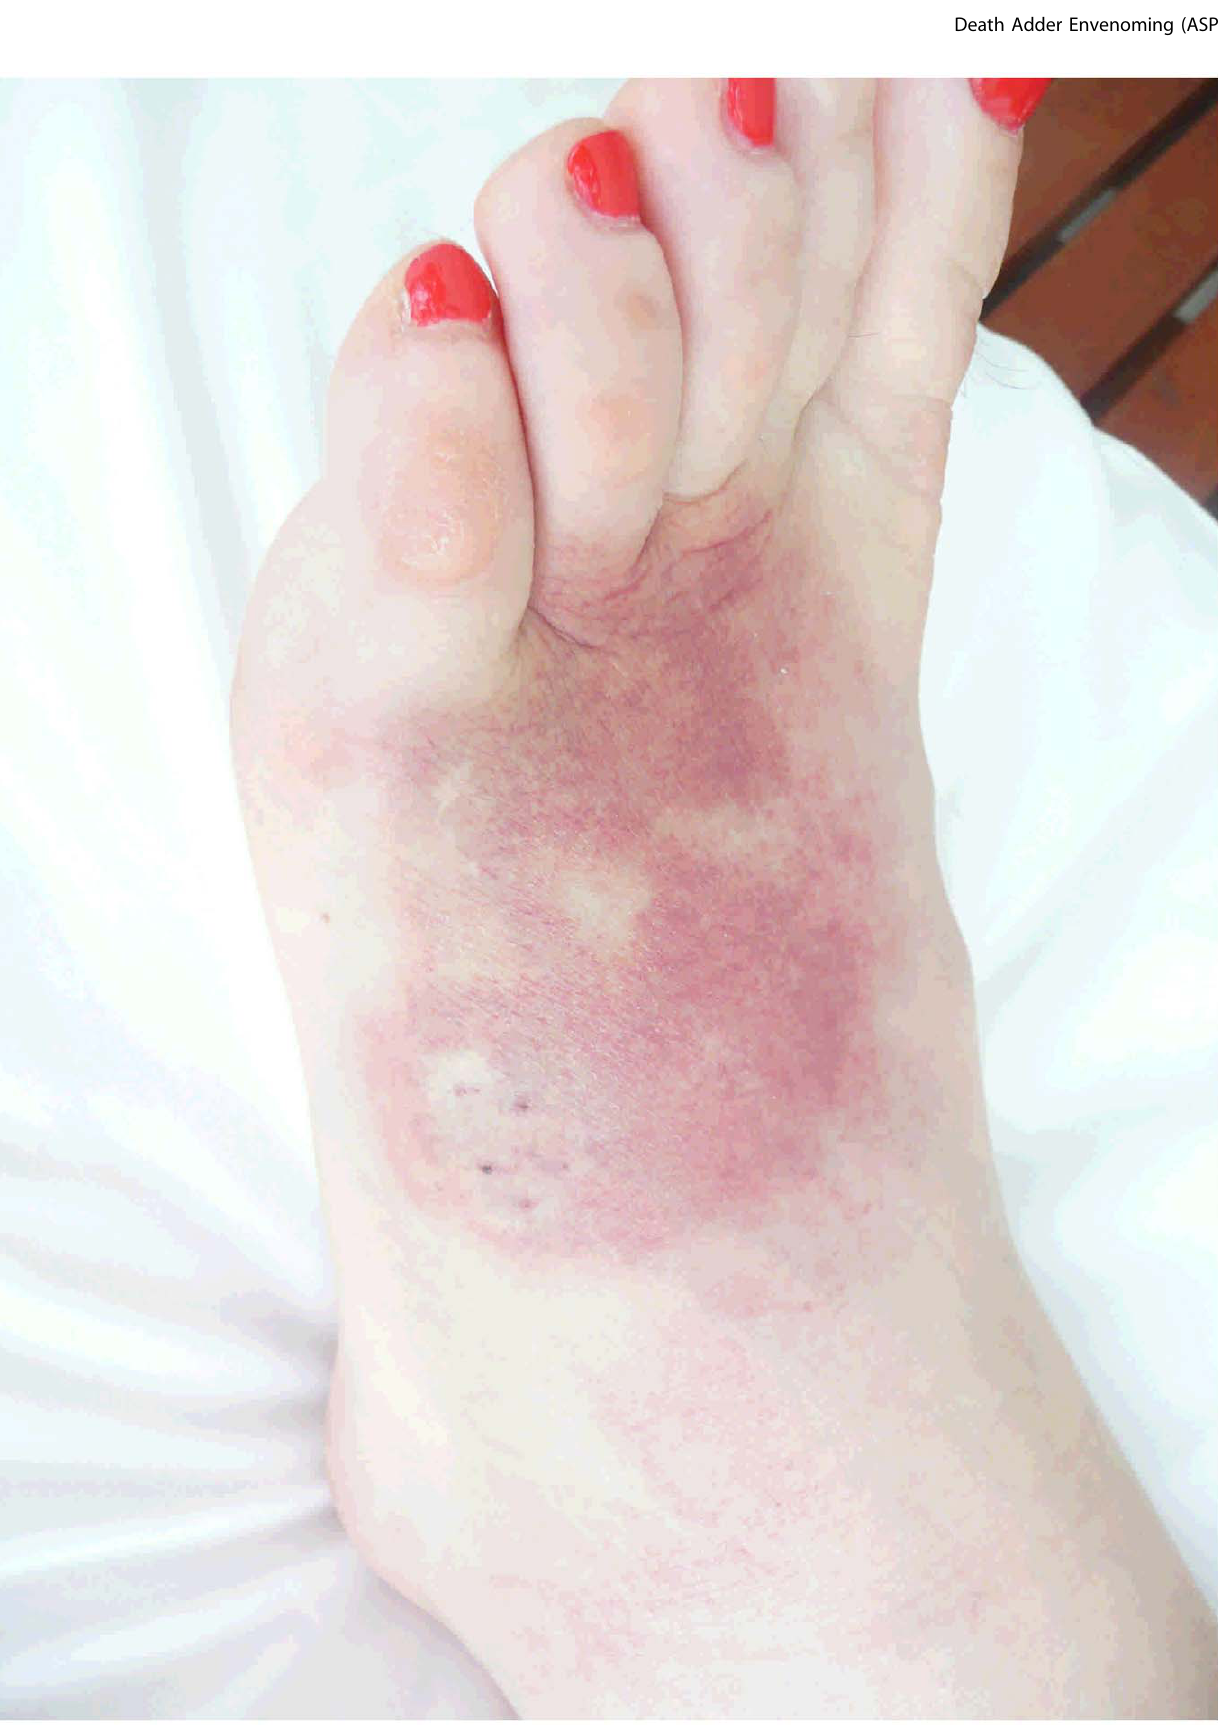
Figure 2. Local effects from a death adder bite to the foot. doi:10.1371/journal.pntd.0001841.g002 PLOS Neglected Tropical Diseases |